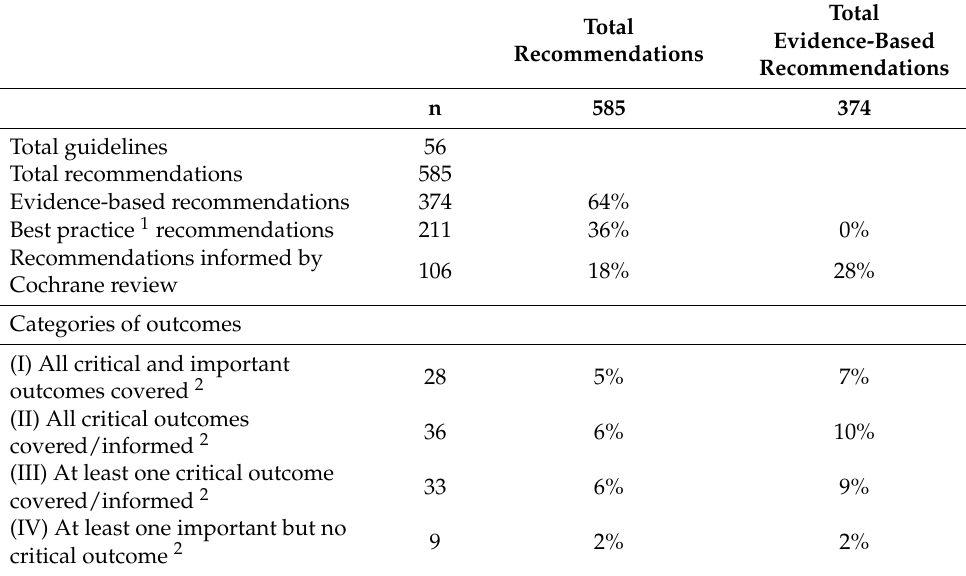
Table 1. Recommendations in Danish National Clinical Guideline development between 2014 and